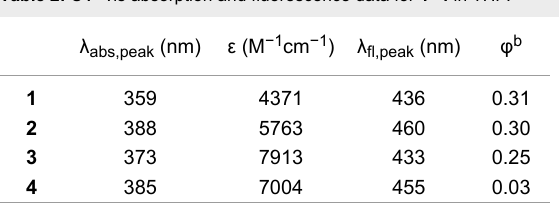
Table 2: UV–vis absorption and fluorescence data for 1 – 4 in THF. a λ abs,peak (nm)